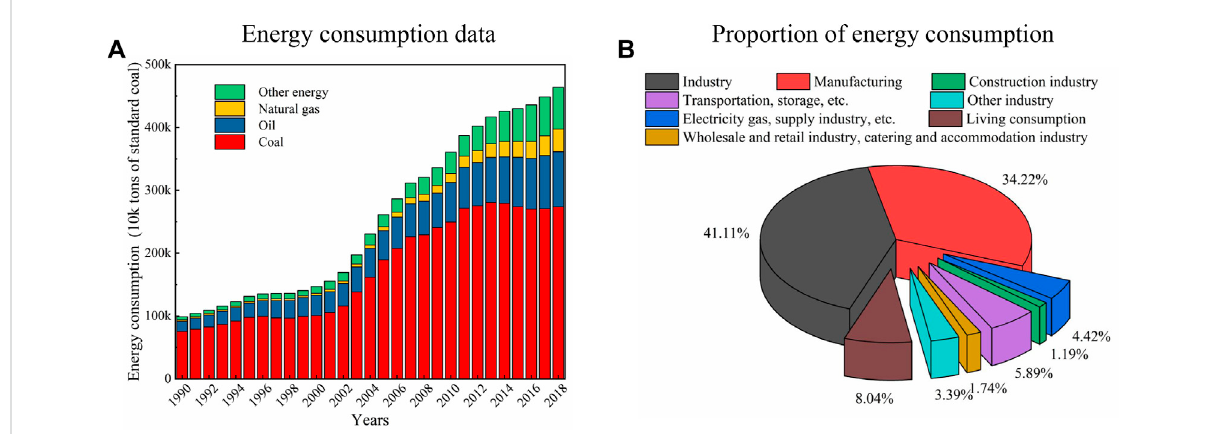
FIGURE 1 Energy consumption in different years and various fi elds in China. (A) Energy consumption data. (B) Proportion of energy